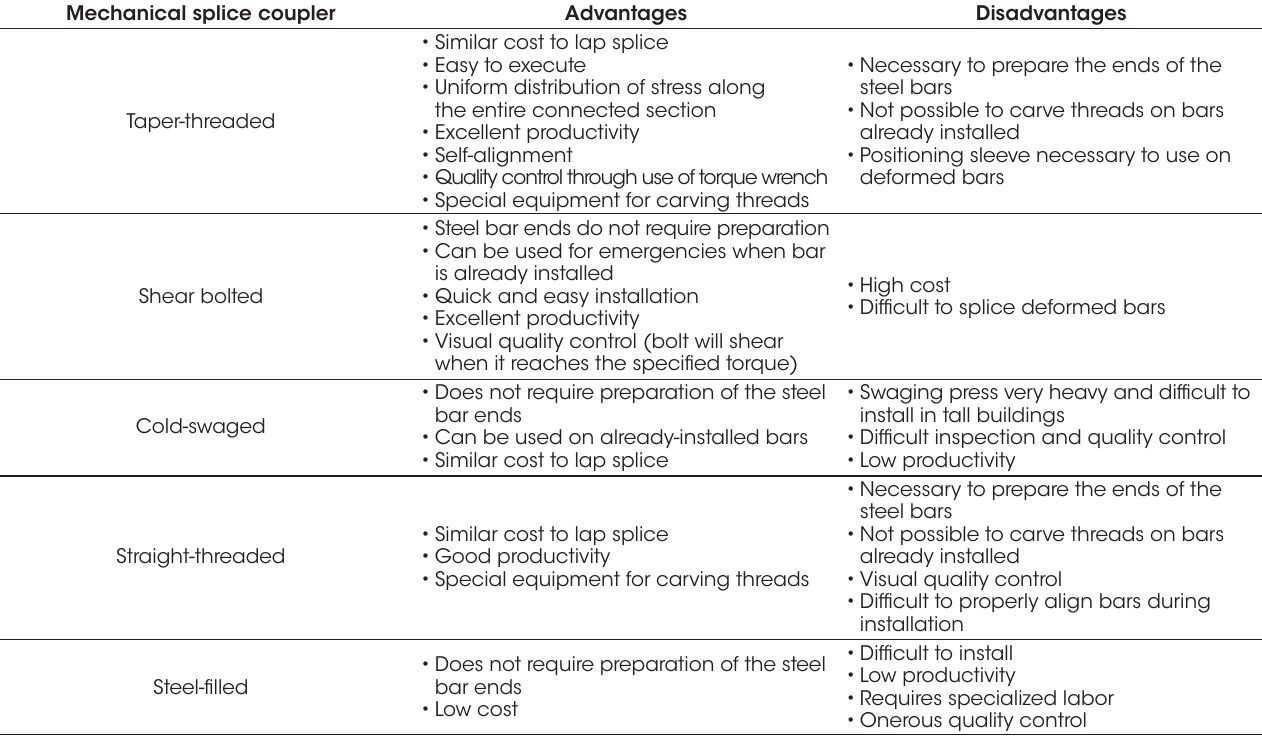
Mechanical splice couplers available on the brazilian market